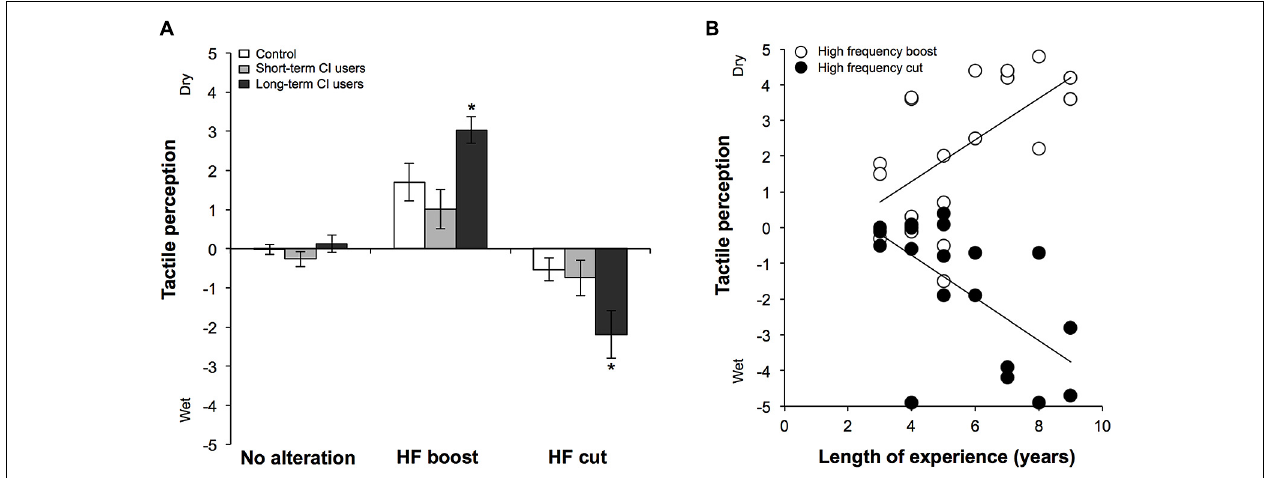
FIGURE 1 | (A) Changes in palmar skin perception during the parchment-skin illusory task in the control, short-term and long-term CI users without modification of the auditory signal (no alteration), with accentuated high frequencies (HF boost) or with attenuated high frequencies (HF cut).